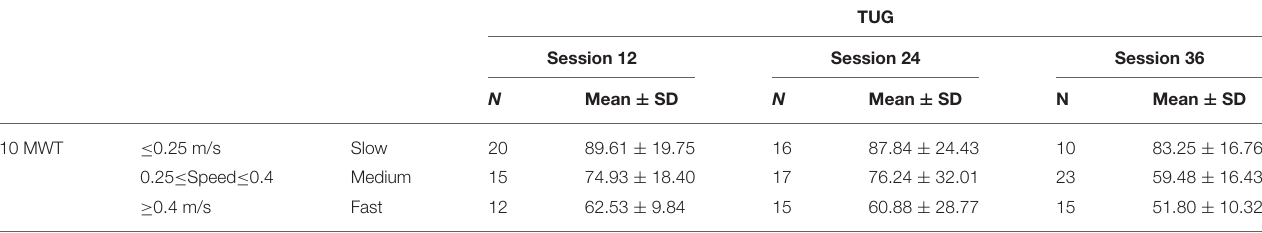
TABLE 7 | Average TUG by velocity sub-groups of 10MWT